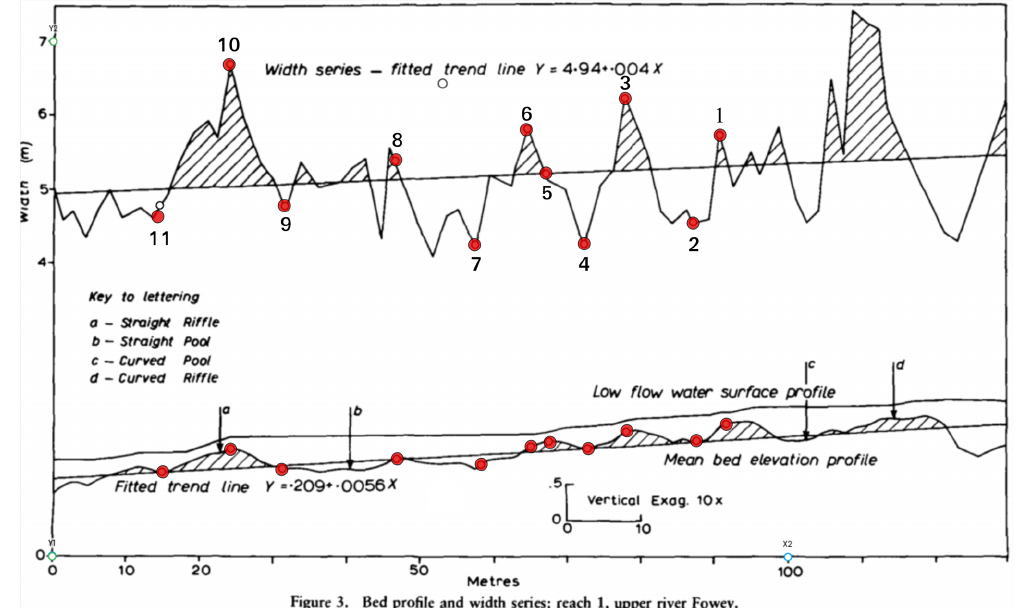
Figure B1. Modified Fig. 3 of Richards (1976) showing the locations of channel width and elevation profile measurements indicated by the open circles. The width series is at the top of the image, and the elevation profile series is at the bottom. Values are in meters. Flow is right to left in the image.